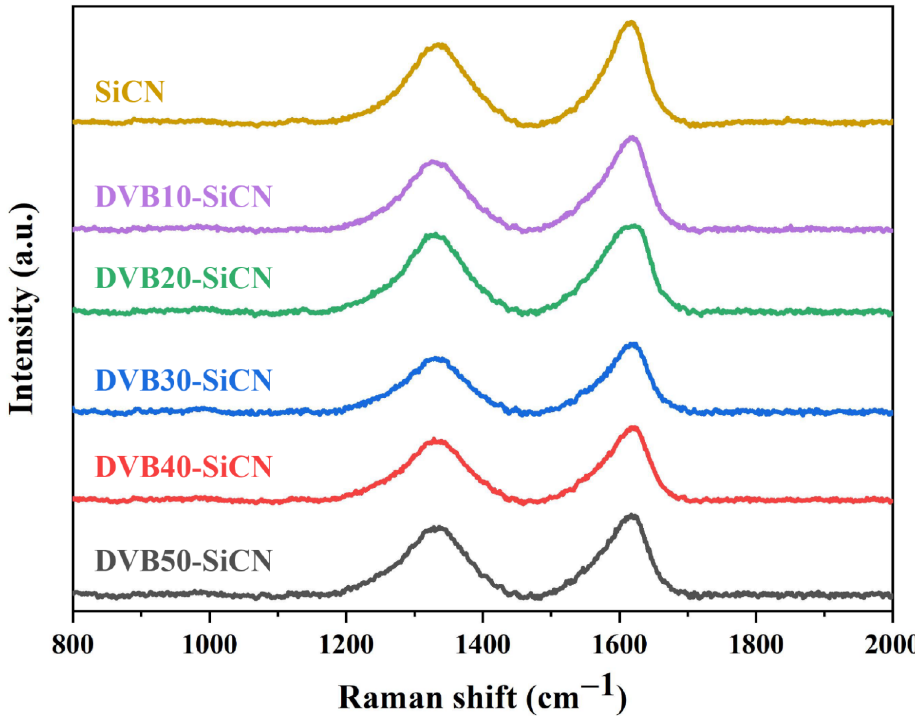
Figure 5. Raman spectra of SiCN films modified with different concentrations of DVB. Table 2. The intensity ratio of D peak to G peak I D / I G and carbon cluster size L a obtained from the curve-fitting of Raman